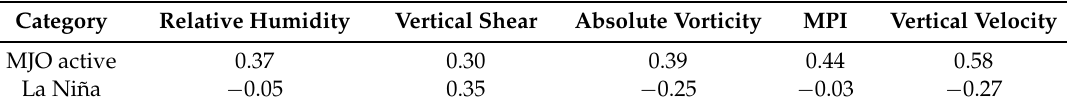
Table 2. Correlation coefficients of the spatial distributions of each factor contributing to the GPI anomaly over the tropical Indian Ocean between 2011 and MJO active years and between 2011 and La Niña years. MPI: Maximum potential intensity. Category Relative Humidity Vertical Shear Absolute Vorticity